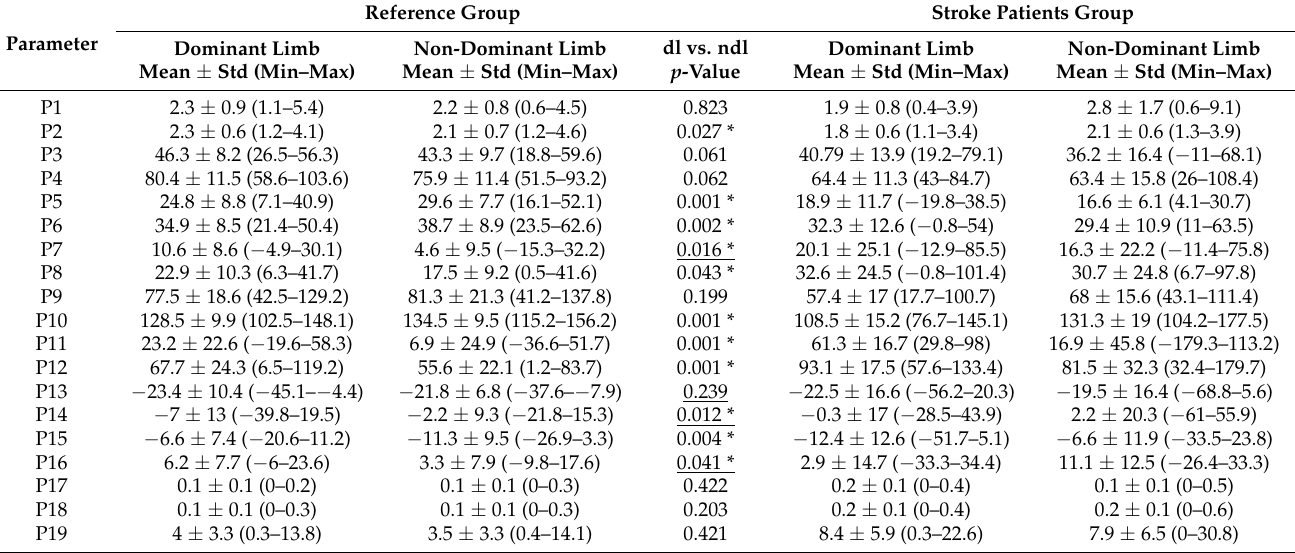
Table 2. Results of the 30 selected input parameters for the reference group and the stroke pa- tient